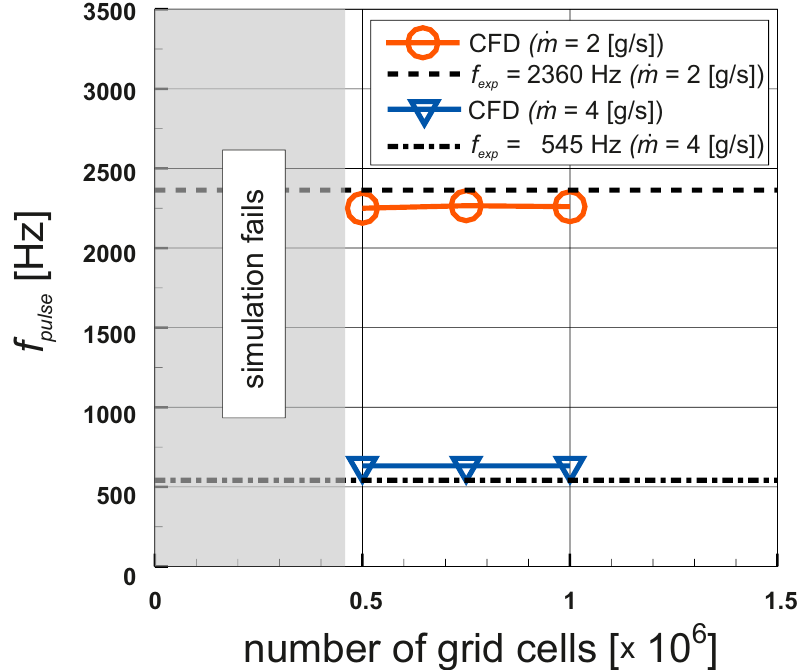
Figure 9. Grid independence study and experimental